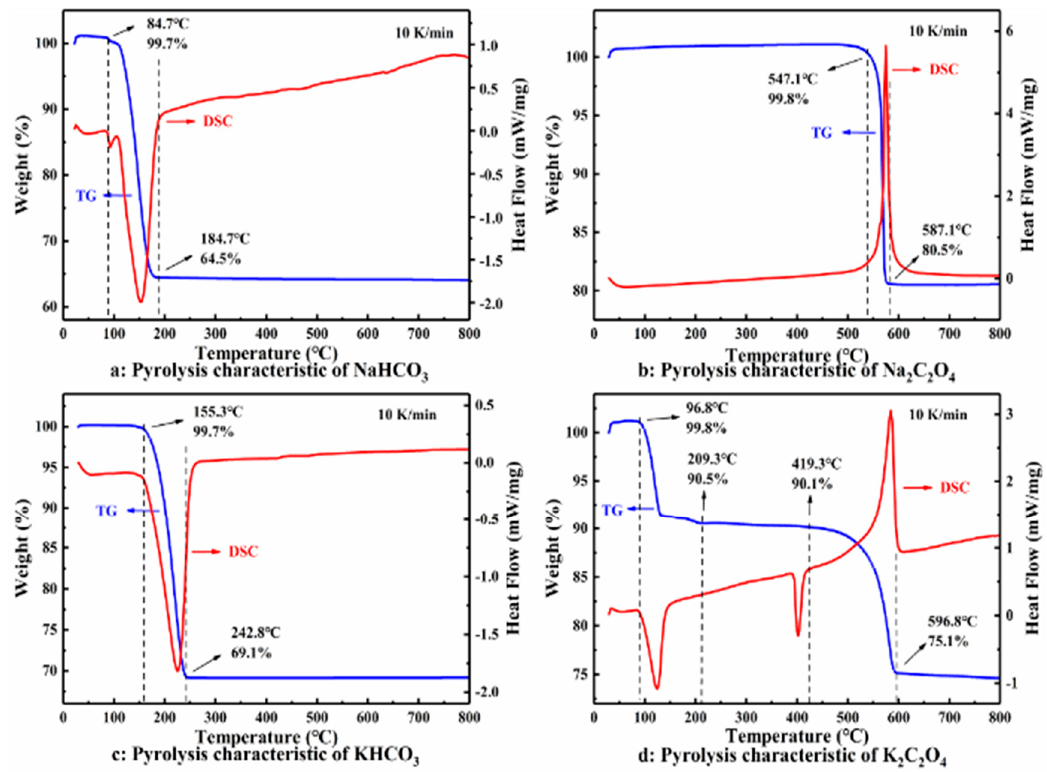
Figure 11. Pyrolysis characteristics of the four inert powders.